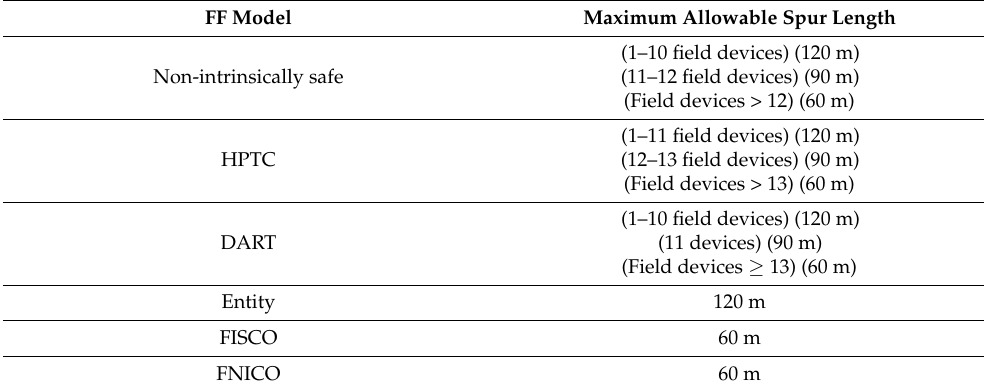
Table 3. Illustration of maximum allowable spur lengths in different FF models according to simula- tion results obtained from Emerson Segment Design